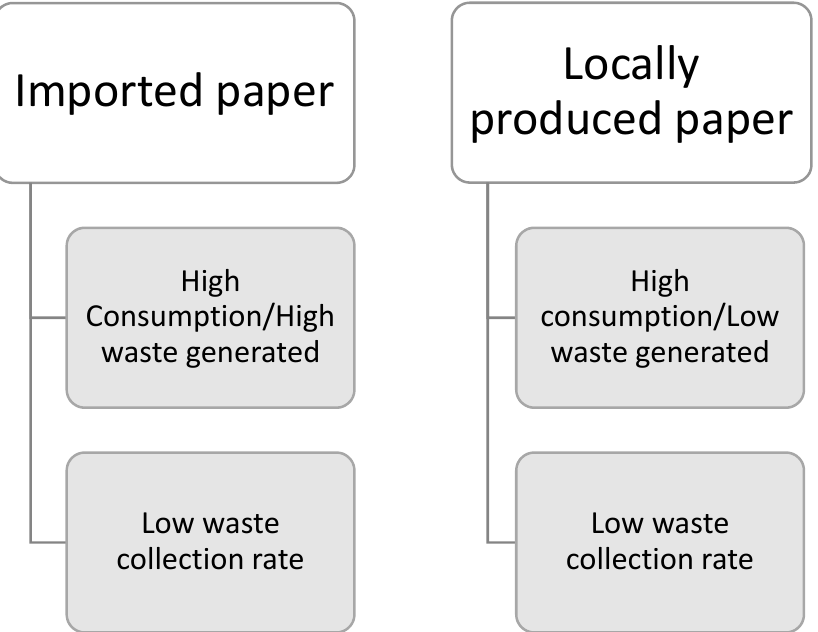
Figure 4. Paper product sources, waste generation, and collection rate. Data Source [28].